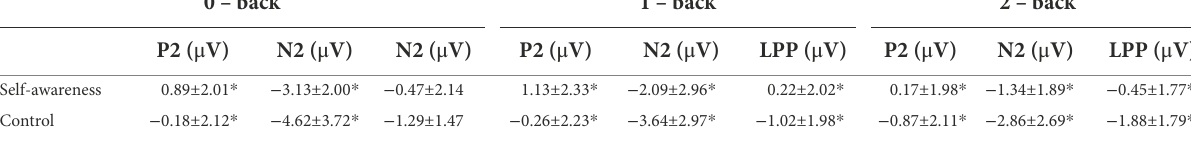
TABLE 2 Descriptive statistics of amplitudes of P2/N2/LPP (M ±